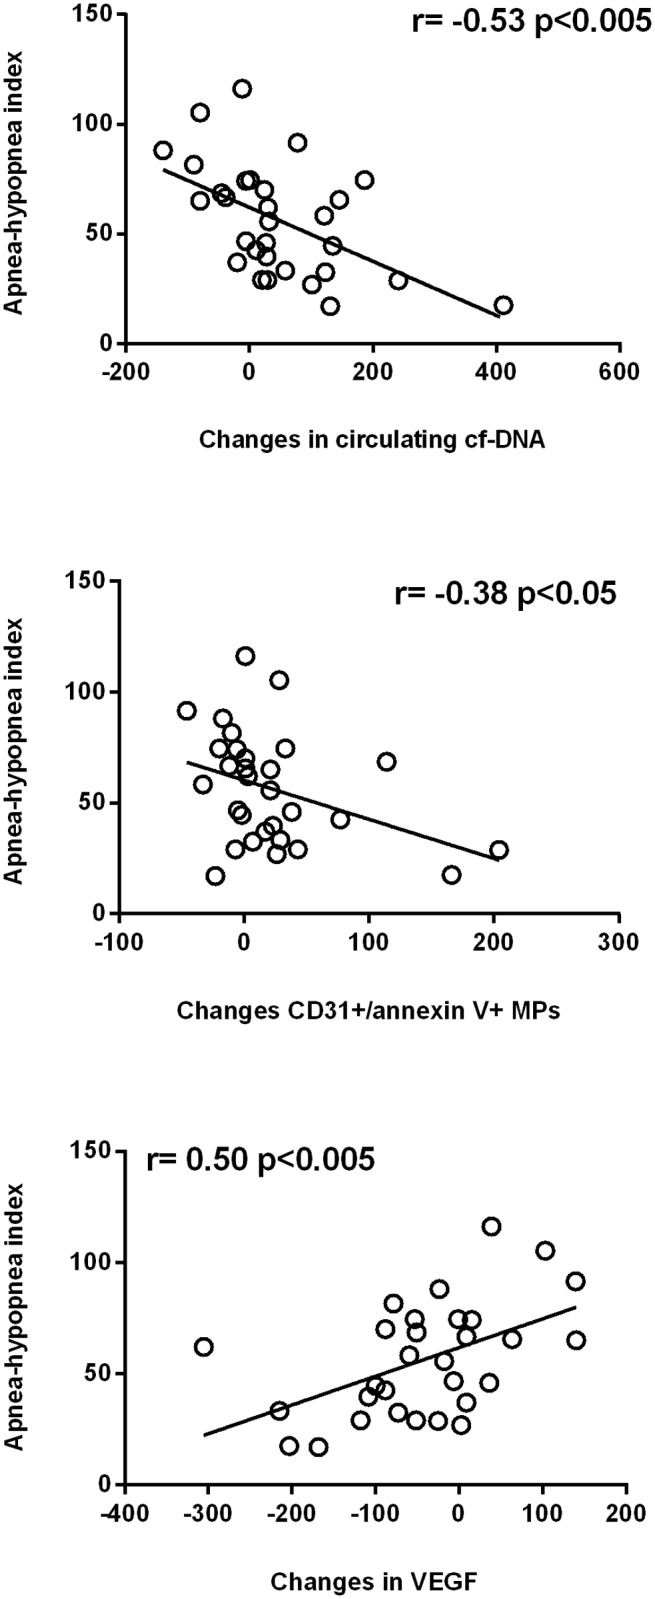
Relationship among the severity of the disease measured according to the apnoea-hypopnea index and changes from baseline in circulating cf-DNA, CD31+/annexin V+ MPs and vascular endothelial growth factor (VEGF).